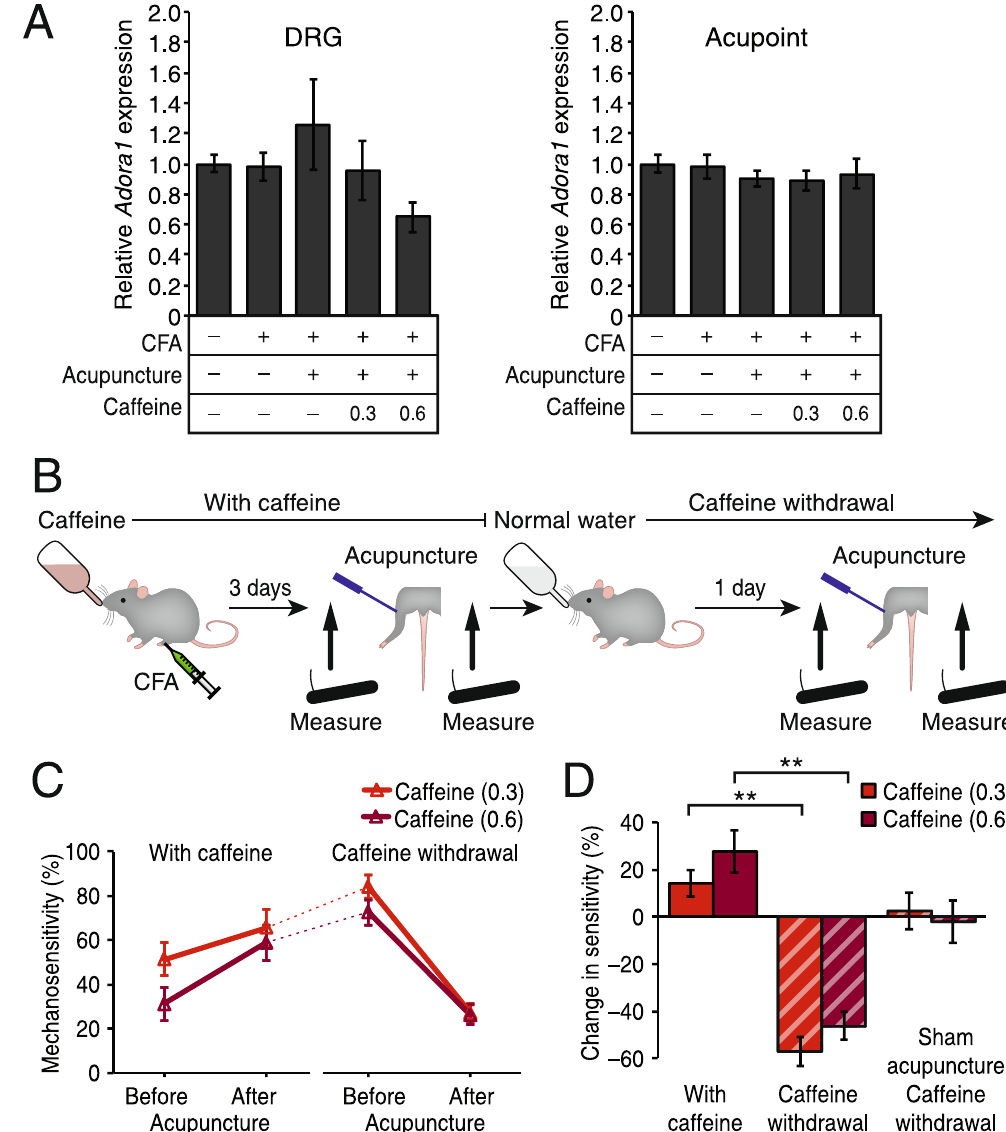
Figure 4. Caffeine did not modulate expression of the adenosine A1 receptor in DRG and tissue around the acupuncture point. ( A ) qPCR analysis of Adora1 expression relative to untreated control mice (without CFA administration, caffeine drinking, and acupuncture treatment) in the ipsilateral L3-L5 dorsal root ganglia (DRG, left panel ) and muscle tissue near the acupuncture point (Acupoint, right panel ). Expression of Adora1 was not significantly altered by acupuncture treatment and chronic oral administration of caffeine. N = 5–8; p > 0.1. ( B ) Schematic diagram depicting how the effect of caffeine withdrawal was evaluated. Mice were acclimated to drinking water containing caffeine for 1 week. Pain was induced by CFA administered in the ankle joint 3 days prior to the measurements of mechanical sensitivity, before and after acupuncture. Following the measurement of after-acupuncture condition, caffeine-containing water was replaced with normal water for 24 hours (Caffeine withdrawal), and then sensitivity was re-assessed before and after acupuncture. ( C ) Mechanical sensitivity repeatedly measured on two consecutive days with or without systemic caffeine. Withdrawal of caffeine (0.3 mg/ml, red; 0.6 mg/ml, dark red) restored the efficacy of acupuncture. N = 7–8. ( D ) Summary histogram of acupuncture-induced changes in sensitivity that are shown in panel F. The analgesic effect of acupuncture was blocked when the mice were administered caffeine via drinking water (With caffeine) but was fully restored after caffeine withdrawal (Caffeine withdrawal, bars with hatched lines). Sham acupuncture after withdrawal did not affect the mechanosensitivity. N = 7–8. ** p < 0.001. Displayed are means ± S.E.M. in A , C , D